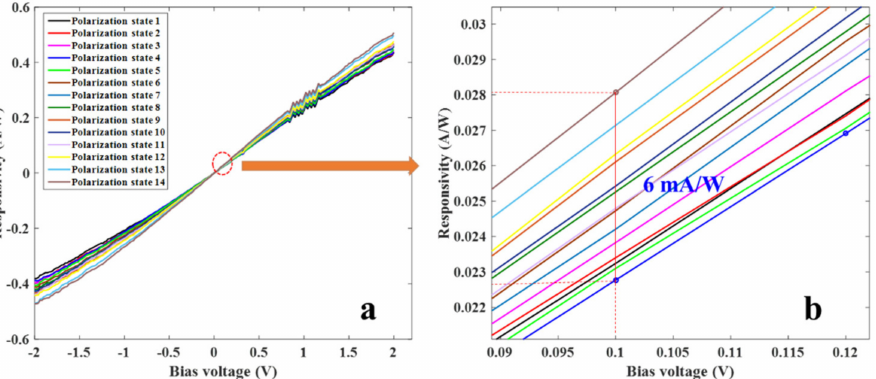
Figure A8. Polarization-sensitive responsivity. ( a ) The dependence of responsivity on bias voltage for different polarization states. ( b ) The zoomed-in view of responsivity for bias voltage values in the range of 0.08 to 0.115